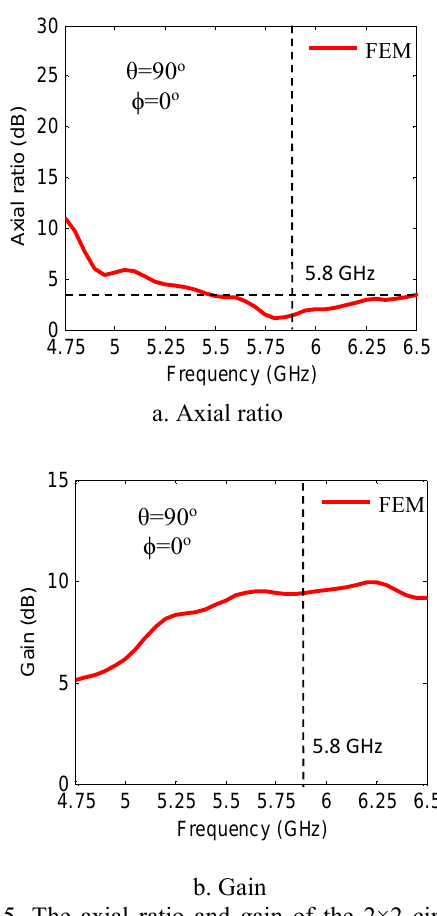
Fig.15. The axial ratio and gain of the 2×2 circularly polarized DRA array elements mounted on a cylindrical ground plane placed inside a reader device in the presence of human hand model with the same dimensions as in Table